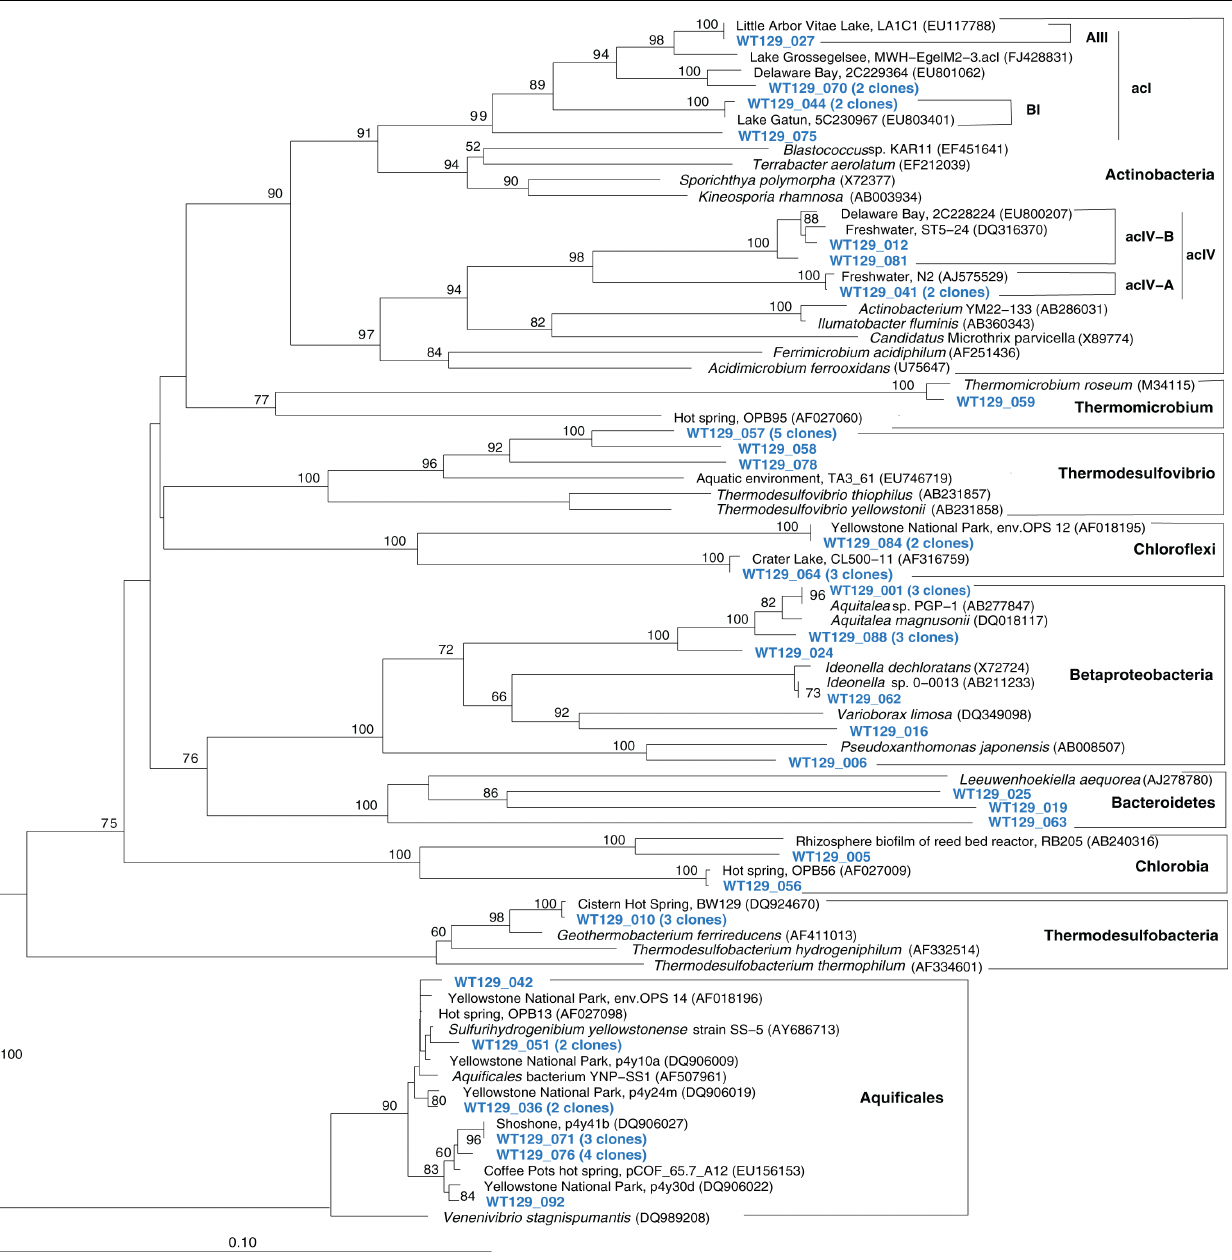
sulfur and hydrogen as electron donors. As a caveat, S. yellowsto- nense, the closest relative to the Yellowstone Lake clones in this dataset, oxidizes sulfur and thiosulfate, but not